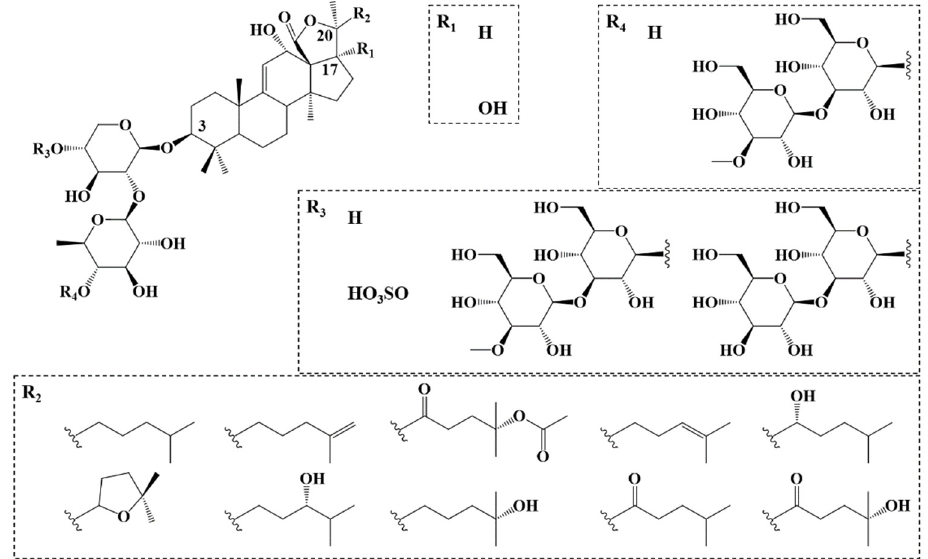
Figure 1. General structure of the Holothuria scabra saponins [17] containing a holostanol aglycone with different side groups, including a C3-anchored glycan presenting a sulfate group on the first monosaccharidic unit.